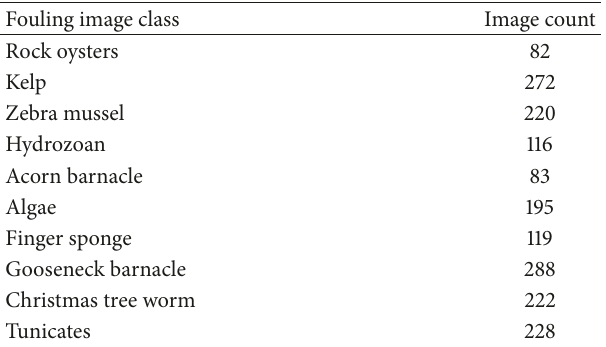
Table 1: Different classes and number of fouling